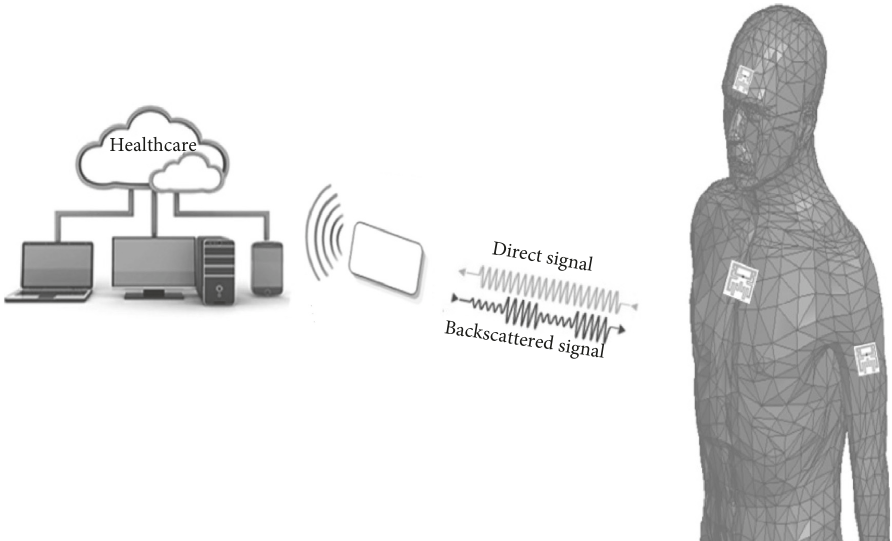
Figure 1: Concept of the RFID epidermal backscattering